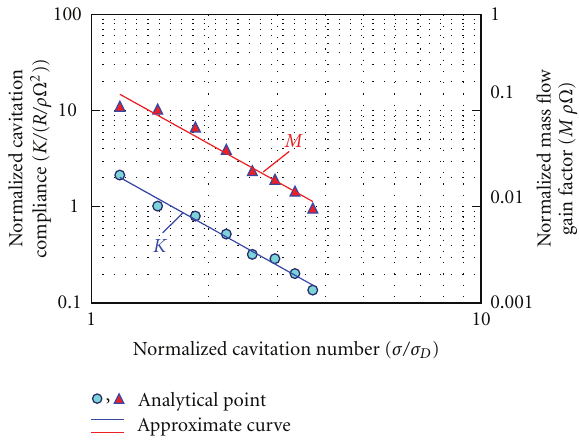
Figure 8: Cavitation characteristics ( K and M ) obtained with quasisteady state CFD analyses.